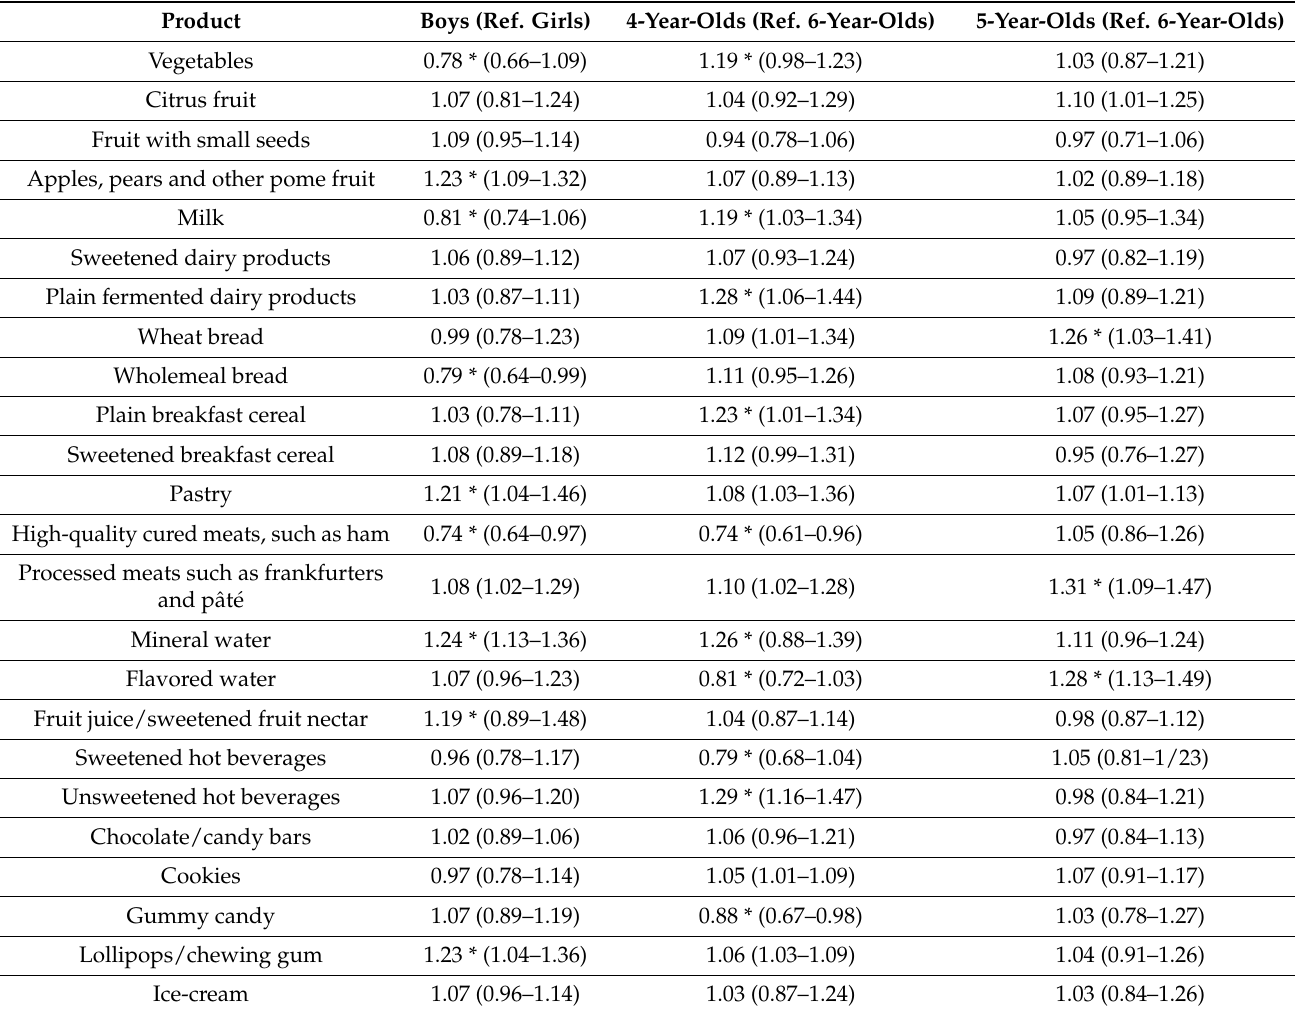
Table 2. Odds ratio (95% confidence interval). The association between liked foods and dishes and the respondents’ age and gender.